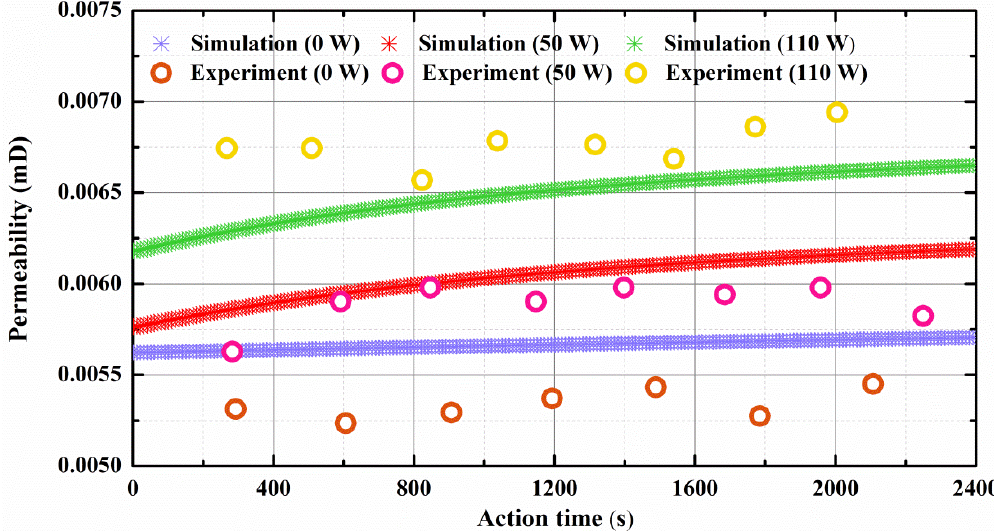
Figure 4. Simulation and experimental results of coal permeability under ultrasonic waves action.